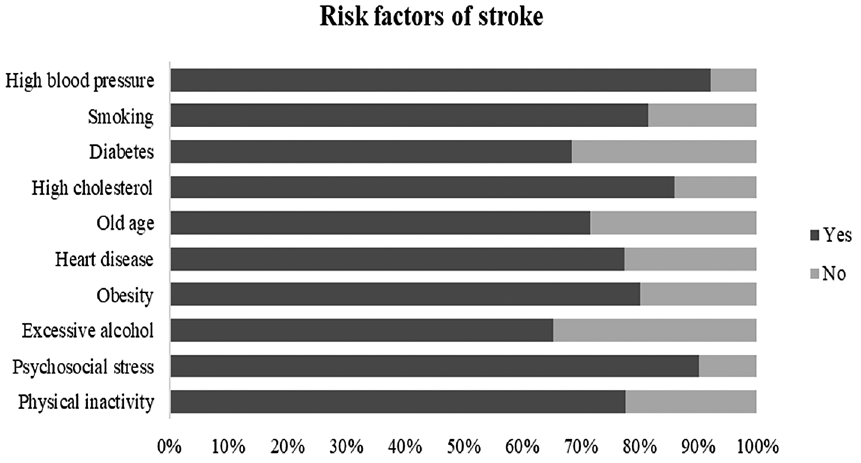
Figure 2. Identification of stroke risk factors.